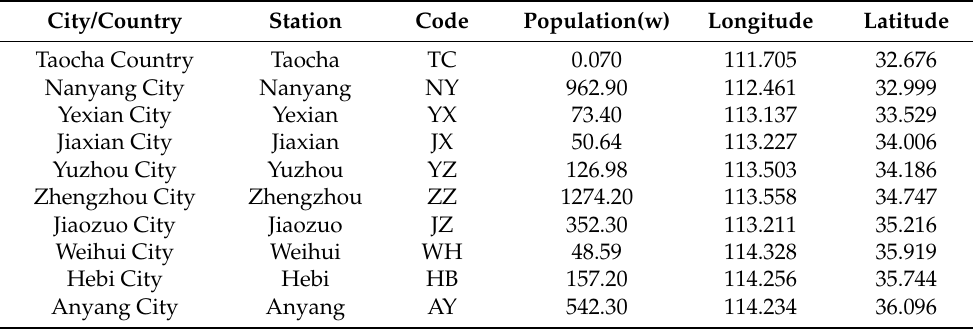
Table 1. Locations of sampling stations in the MRP of the SNWD in Henan